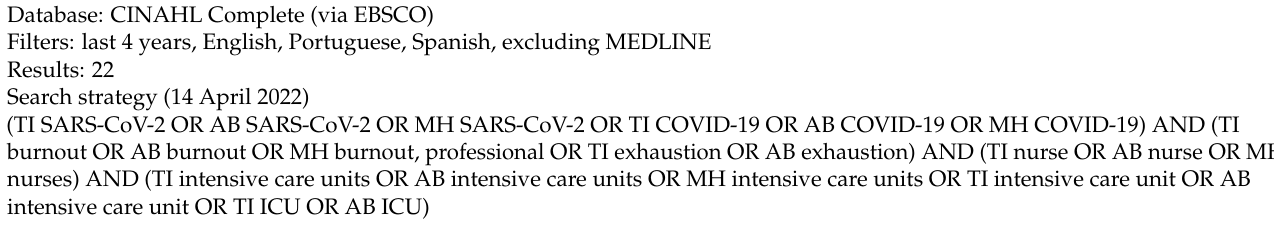
Table 1. Database search strategy and